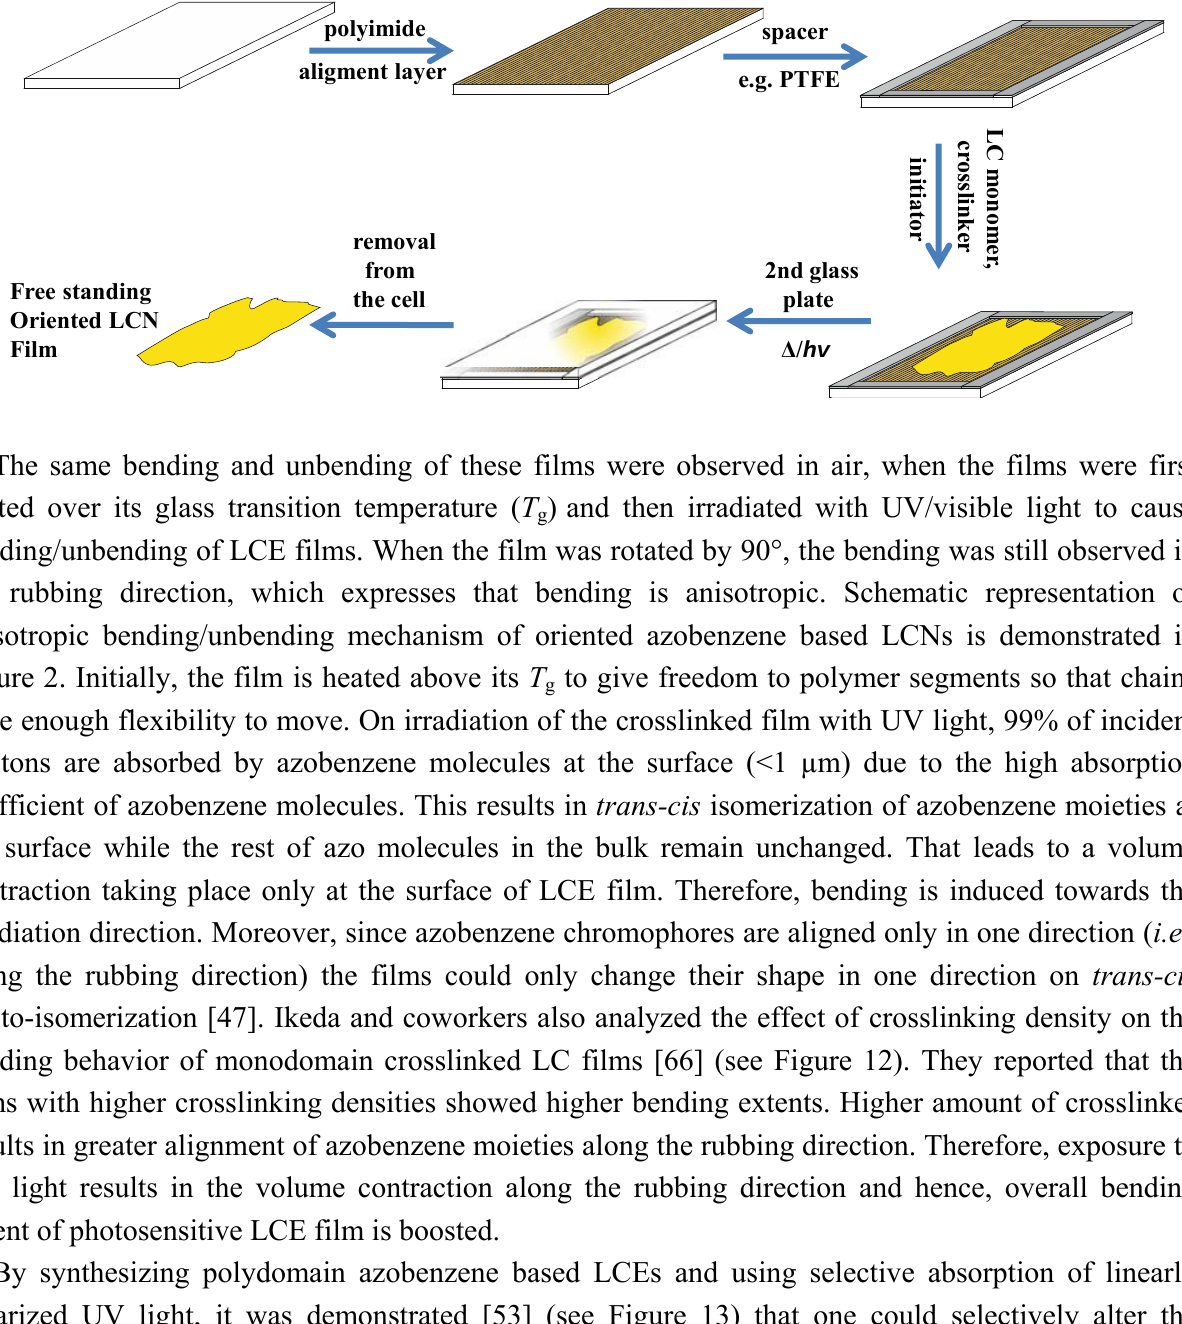
Figure 11. Schematic representing the fabrication procedure for synthesis of oriented LCE films. Initially the glass slabs are spin coated with polyimide and baked, followed by rubbing of these films to yield alignment layers. Then monomer, crosslinker and initiator is sandwiched between the coated glass plates and polymerized using heat/UV. The resulting film is then removed from the